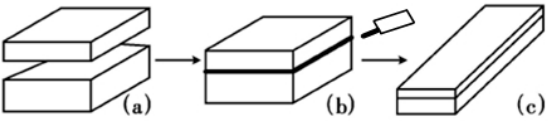
Figure 1. Schematic of vacuum rolling cladding. ( a ) Surface cleaning and blanks assembling; ( b ) vacuum electron beam welding (VEBW); ( c ) Hot rolling.